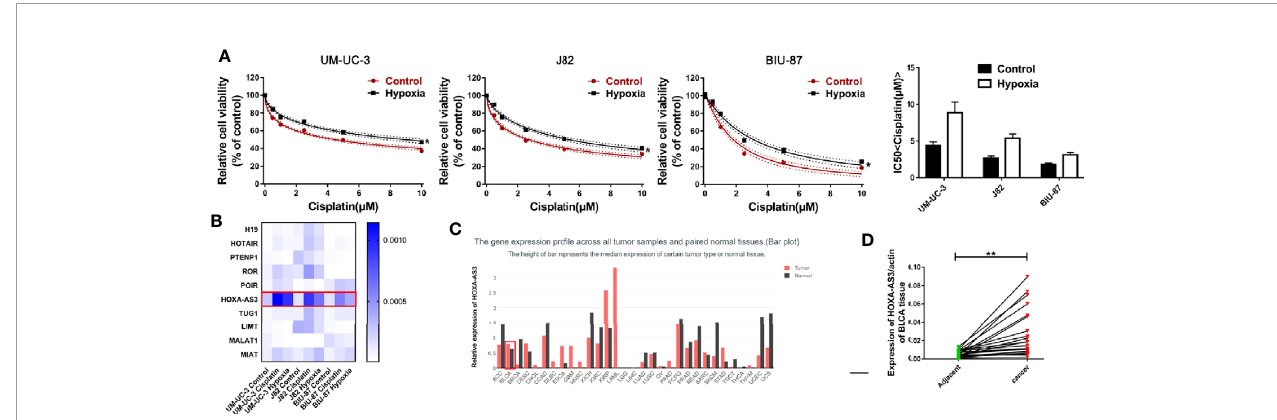
FIGURE 1 | Hypoxia induces cisplatin resistance and upregulation of HOXA-AS3 in bladder cancer (BC) cells. (A) CCK-8 was used to determine cell viability after treatment with cisplatin under normoxic and hypoxic conditions. *P < 0.05 vs . control. (B) The level of long non-coding RNAs (lncRNAs) after cisplatin treatment under hypoxic or normoxic conditions was examined by qRT-PCR. (C) Gene expression pro fi ling interactive analysis (GEPIA) database analysis of HOXA-AS3 expression in bladder cancer tumor samples and paired normal tissues. (D) Quantitative RT-PCR analysis of HOXA-AS3 levels in bladder cancer tissue and adjacent normal